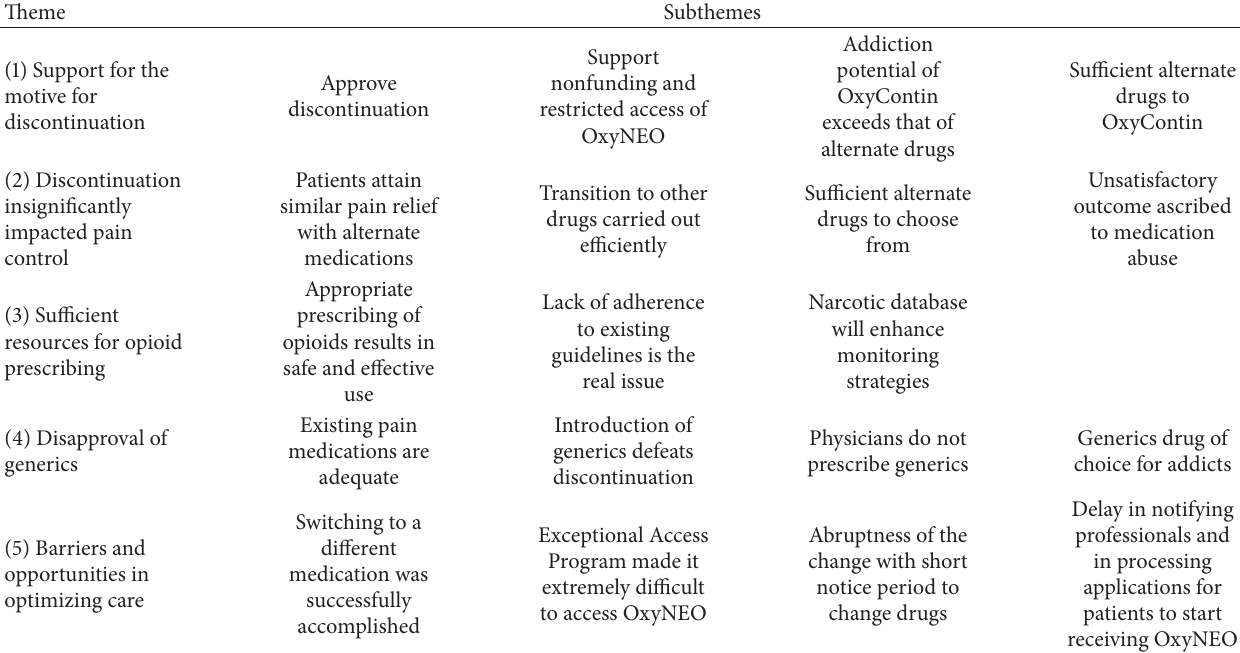
Table 4: Themes identified from physician